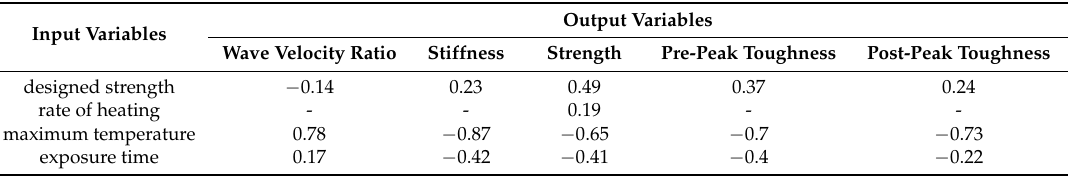
Table 2. Correlation coefficient between input and output variables.